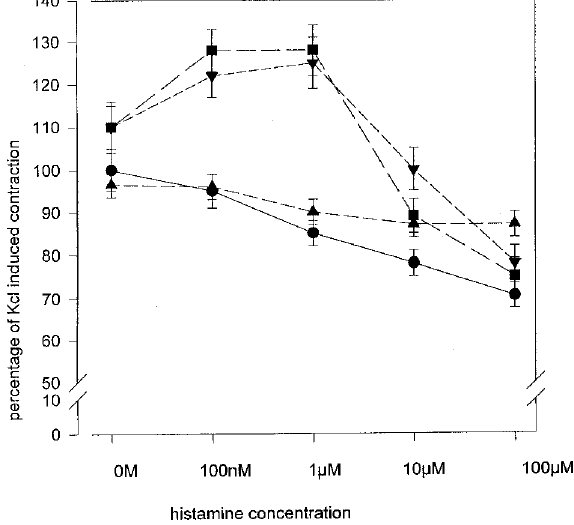
FIG. 1. Dose response curve of histamine in KCl induced contraction: j without epithelium; . epithelium and methyl- ene blue; m epithelium and NMMA; d